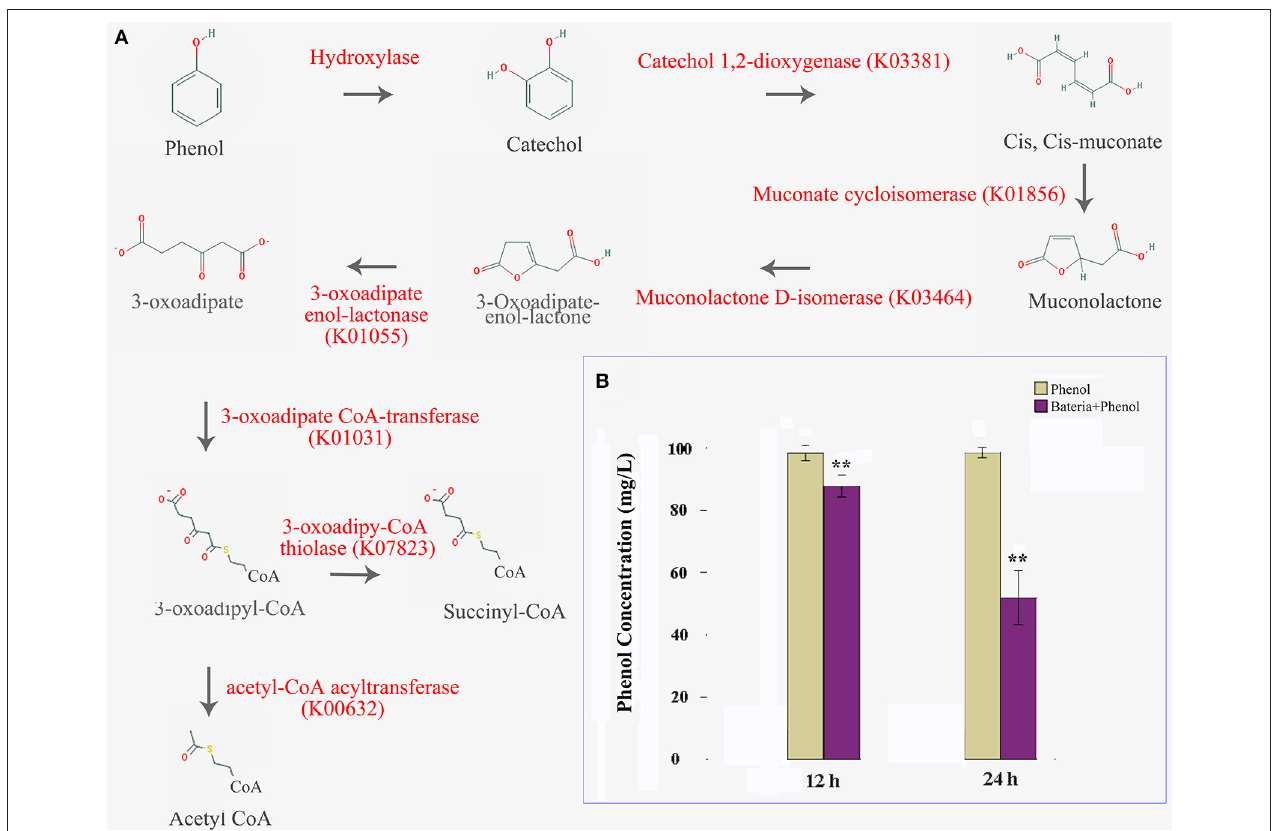
FIGURE 5 | P. xylostella gut bacteria-mediated biodegradation of phenols. Aerobe pathway of phenol biodegradation, enzymes beside the arrow lines are identified from the metagenome (A) , and degradation efficiency at 12 and 24 h after treatment with colored histograms representing different treatments (B) . Yellow column indicated that the phenol media without the presence of bacteria, and the purple indicated that the phenol media with the presence of P. xylostella gut bacteria, the stars ** over the columns within a graph denote significant differences ( p < 0.01) between the different